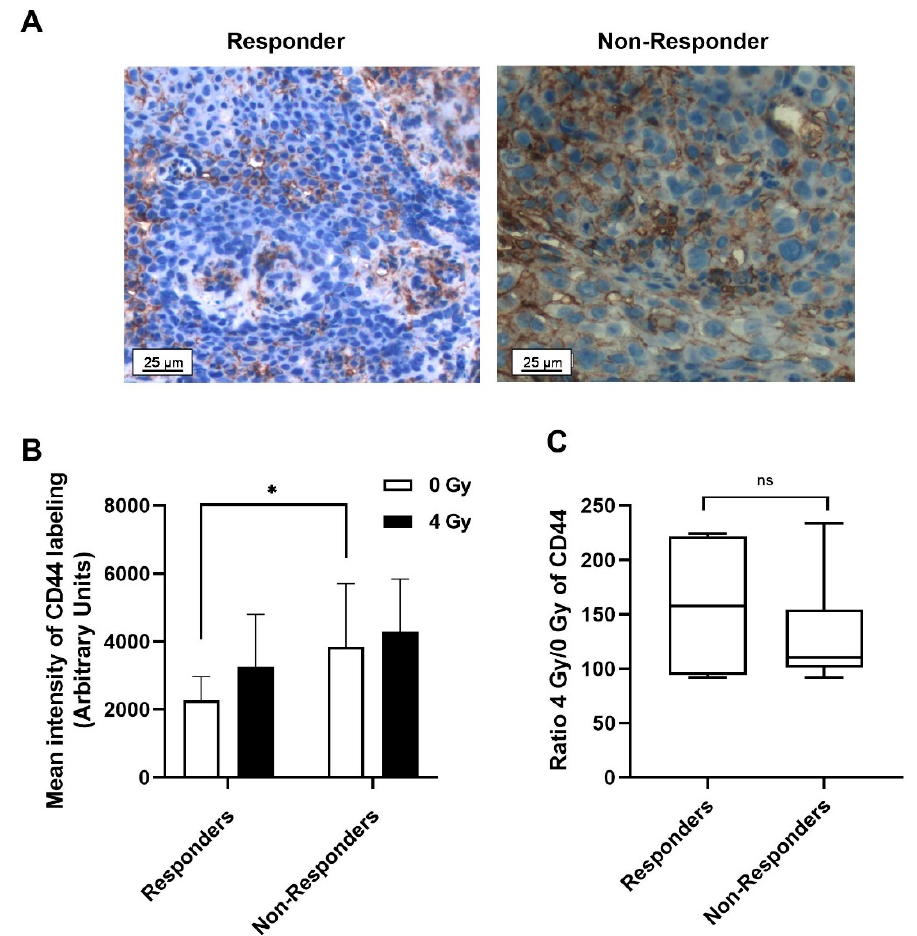
Figure 2. ( A ) Representative immunohistochemical (IHC) staining of CD44 expression of responder and non-responder patients in the biopsy sections maintained in ex vivo culture. ( B ) Mean ± SD of CD44 labelling intensities, quantified using Metafer software (Metasystems, Altlussheim, Germany) for 15 responder and 13 non-responder patients. ( C ) Ratio of CD44 expression after 4 Gy irradiation compared with 0 Gy for responder and non-responder patients. Two slides and a minimum of 200 fields per slide were analysed per condition. Student’s t -test was used for statistical analyses ( ns p > 0.05, * p < 0.05).